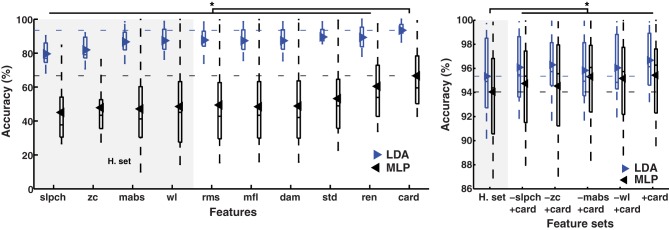
MPR accuracy using only static contractions. Accuracy of myoelectric pattern recognition (MPR) of 11 movements (IM data) using two classifiers (LDA and MLP). Cardinality outperformed previously known features, including the features from the Hudgins set (H. set), individually (left inset) and as part of the H. set (right inset). Only the static part of the contraction was included during signal processing (cTp = 0.4). The marker “*” represents statistical significance at p < 0.05.